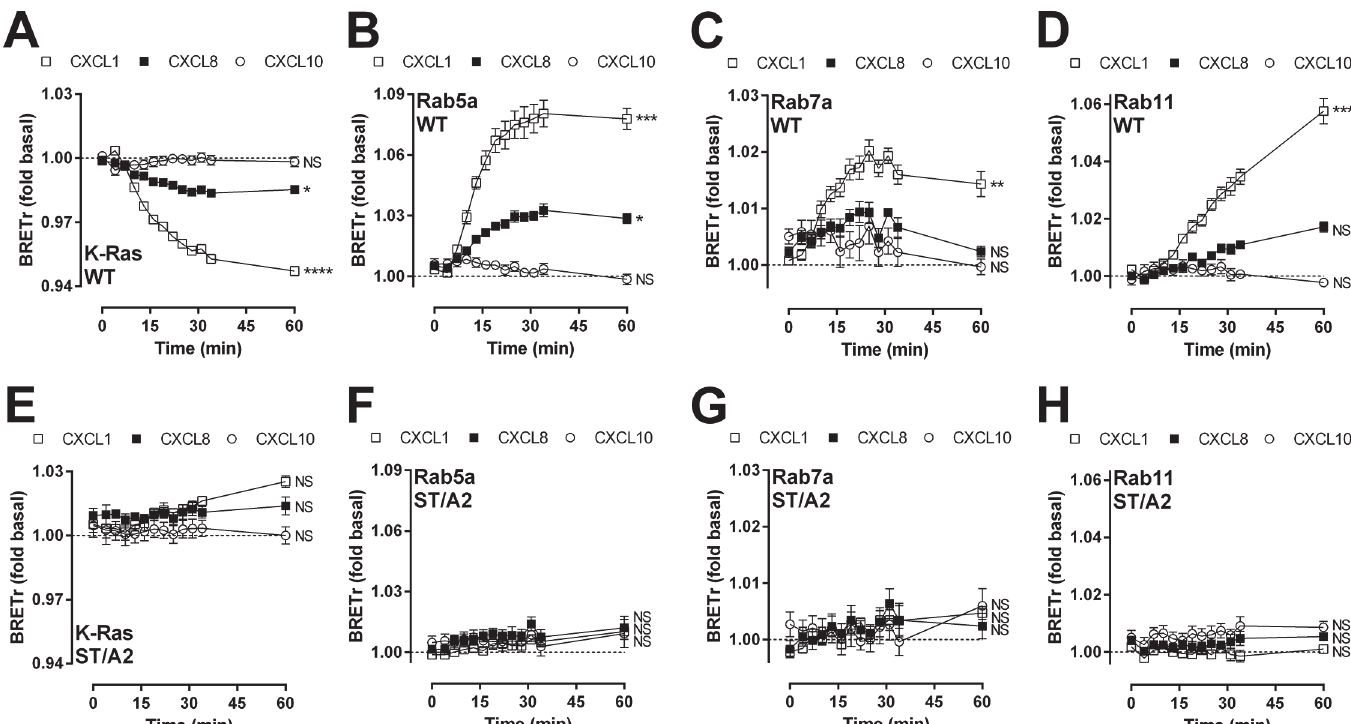
Fig 7. ORF74 internalizes and traffics via early, recycling and late endosomes. HEK293T cells were transiently transfected with ORF74-Rluc8 (WT) (A-D) or ORF74-ST/A2-Rluc8 (ST/A2) (E-H) in combination with Venus-K-Ras (plasma membrane marker) (A, E), Venus-Rab5a (early endosome marker) (B, F), Venus-Rab7a (late endosome/lysosome marker) (C, G) or Venus-Rab11 (recycling endosome marker) (D, H) and stimulated with CXCL1, CXCL8 or CXCL10 for indicated time and BRET was measured. Data are shown as the mean of pooled data from three independent experiments each performed in triplicate. Data is presented as fold over vehicle-stimulated cells (dotted line) and error bars indicate SEM values. Statistical differences between the area under the curve of vehicle- and corresponding CXCL1-, CXCL8- or CXCL10-treated cells (baseline = 1) were determined by one-way ANOVA followed by a Bonferroni test ( **** p (cid:1) 0.0001, *** p (cid:1) 0.001, ** p (cid:1) 0.01, * p (cid:1) 0.05). NS = not